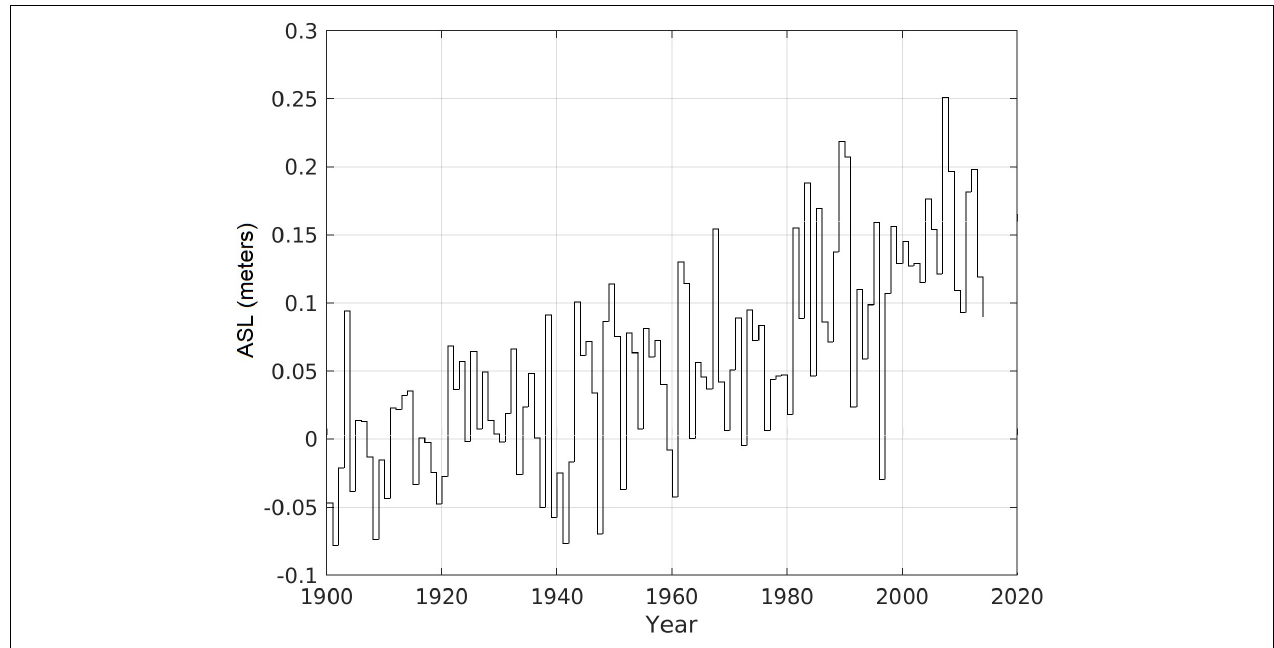
FIGURE 4 | Temporal variations in area averaged annual ASL_SRM in the Baltic